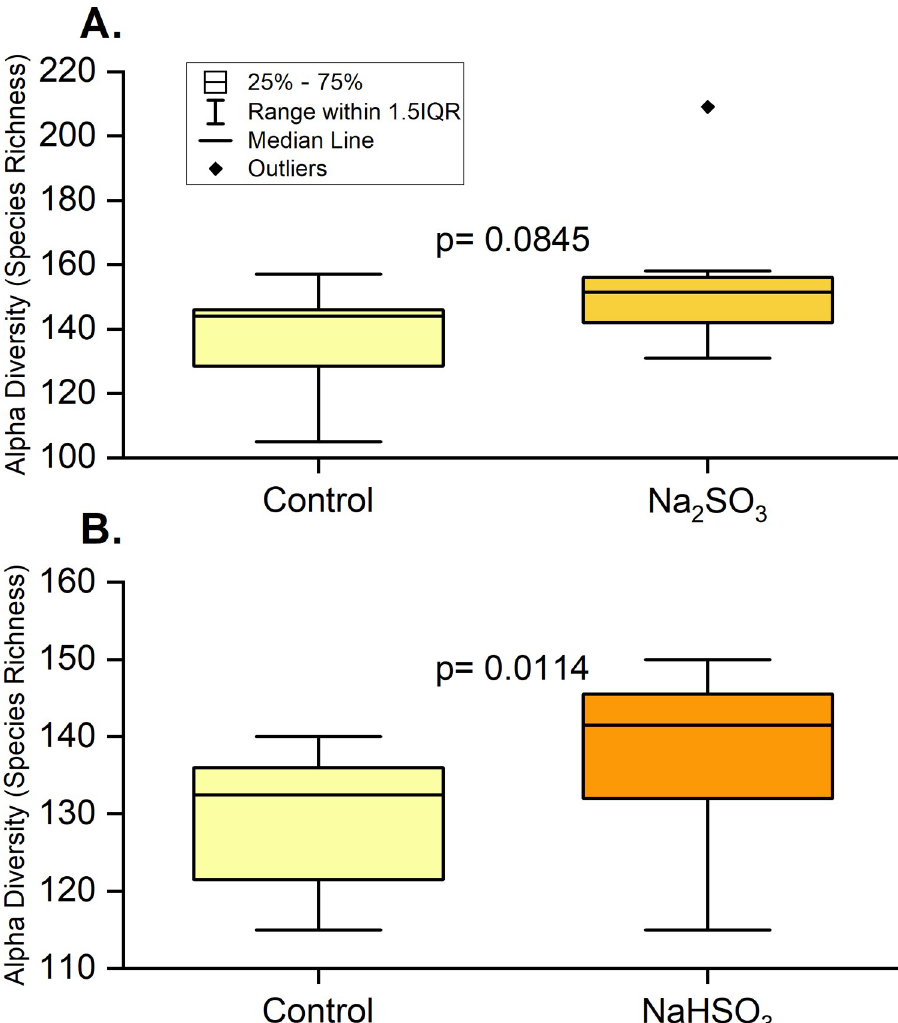
Fig 8. Alpha diversity in F2 samples with sulfite treatment at time 0. 16S rRNA sequencing was used to determine species richness (based on relative abundance) for control and treated samples with Na 2 SO 3 (A) and NaHSO ₃ (B). A paired t-test showed that species richness increased significantly after treatment with NaHSO 3 and was marginally significant after treatment with Na 2 SO 3